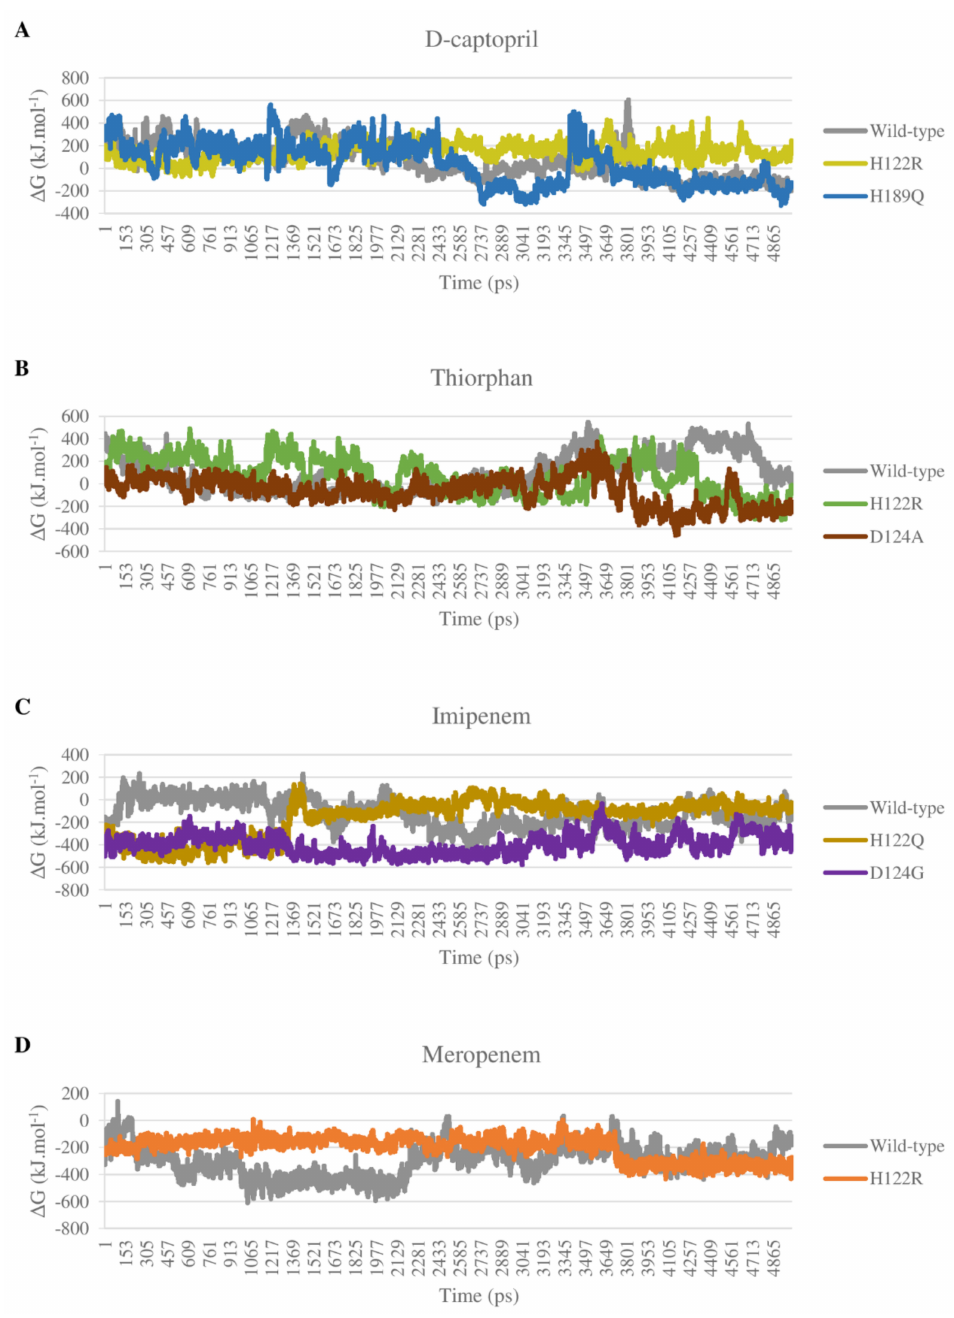
Figure 13. Binding energy of mutant and wild-type complexes with 4 ligands during the MD simulations. ( A ) D-captopril. ( B ) Thiorphan. ( C ) Imipenem. ( D )